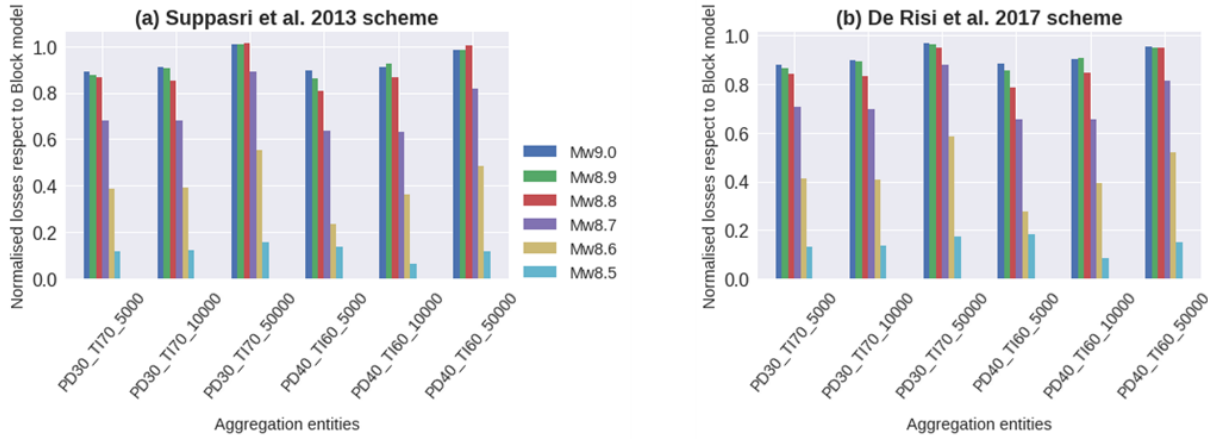
Figure 14. Losses induced by six tsunamis for the six CVT models normalised with respect to the ones at the block level. Tsunami vulnera- bility has been computed using the set of building classes proposed in (a) Suppasri et al. (2013) and (b) De Risi et al. (2017).